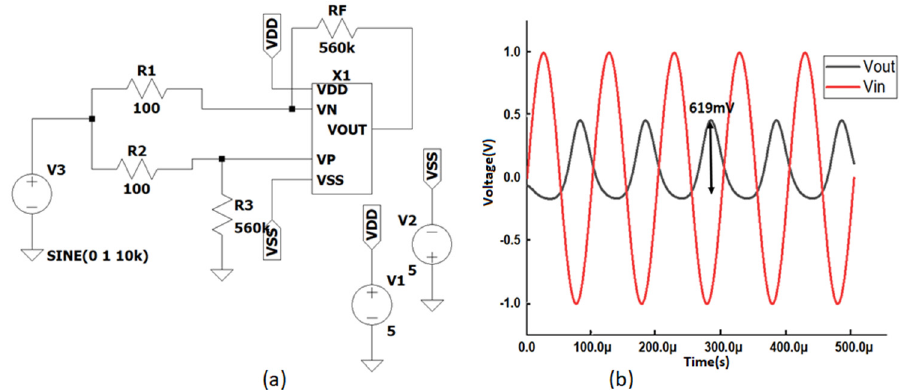
Figure 4. ( a ) Common mode rejection ratio (CMRR) simulation setup. ( b ) Simulation output.